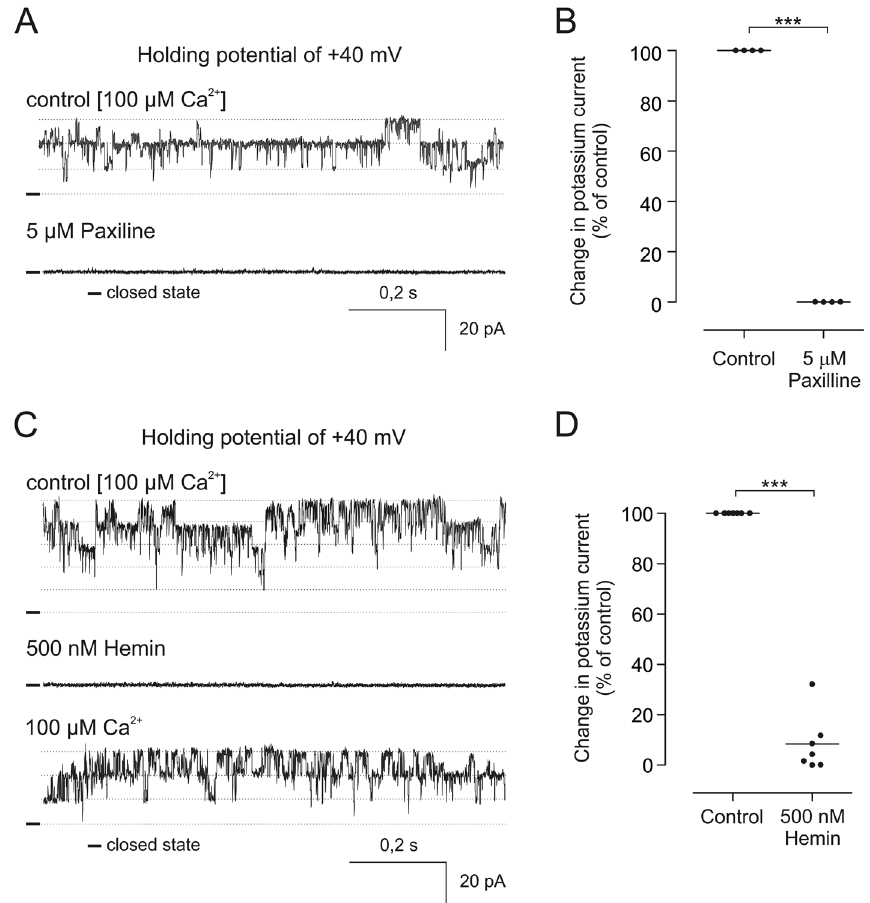
Figure 5. Inhibitory effect of the BK Ca channel blockers on the channel recorded after transfection with VEDEC. ( A ) Single channel recording in symmetrical 150/150 mM KCl of the channel under the control condition and after 5 µM paxilline application. ( B ) Statistical analysis of the paxilline inhibitory effect on the recorded channel. ( C ) Representative single- channel recording of the channel in symmetrical 150/150